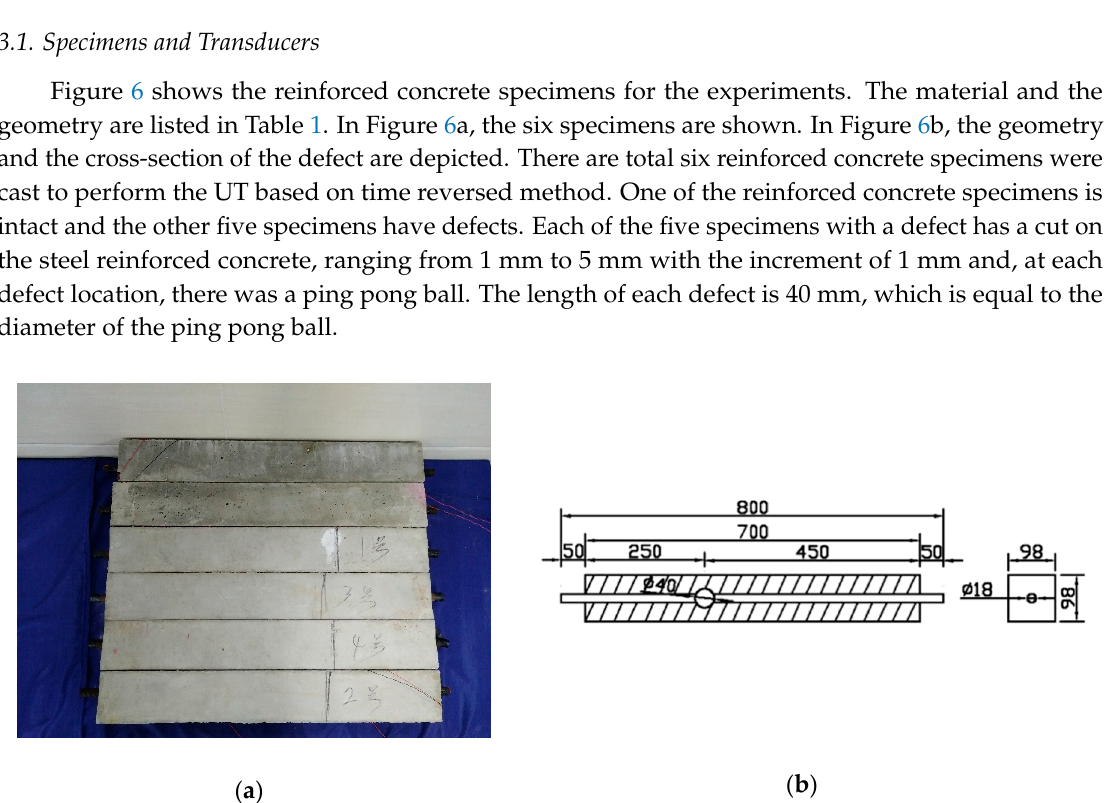
Figure 6. The detecting concrete sample. ( a ) The physical feature of reinforced concrete specimens. ( b ) 3D transparent feature of the sample (mm).